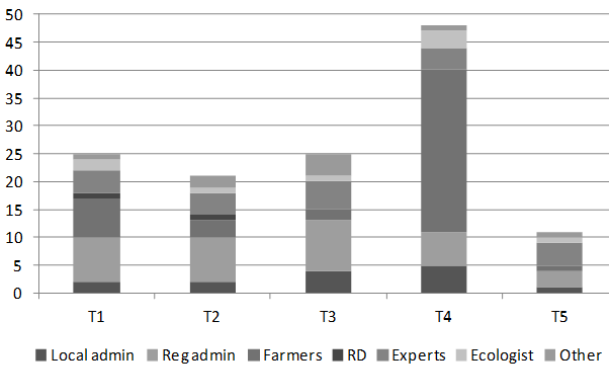
Fig. 4. Number of stakeholders participating in the workshops per category (local administration, regional administration, farmers, rural development groups, experts (law, economics, ecology, and hydrology), ecologist groups, and other (private companies, consumer organizations,